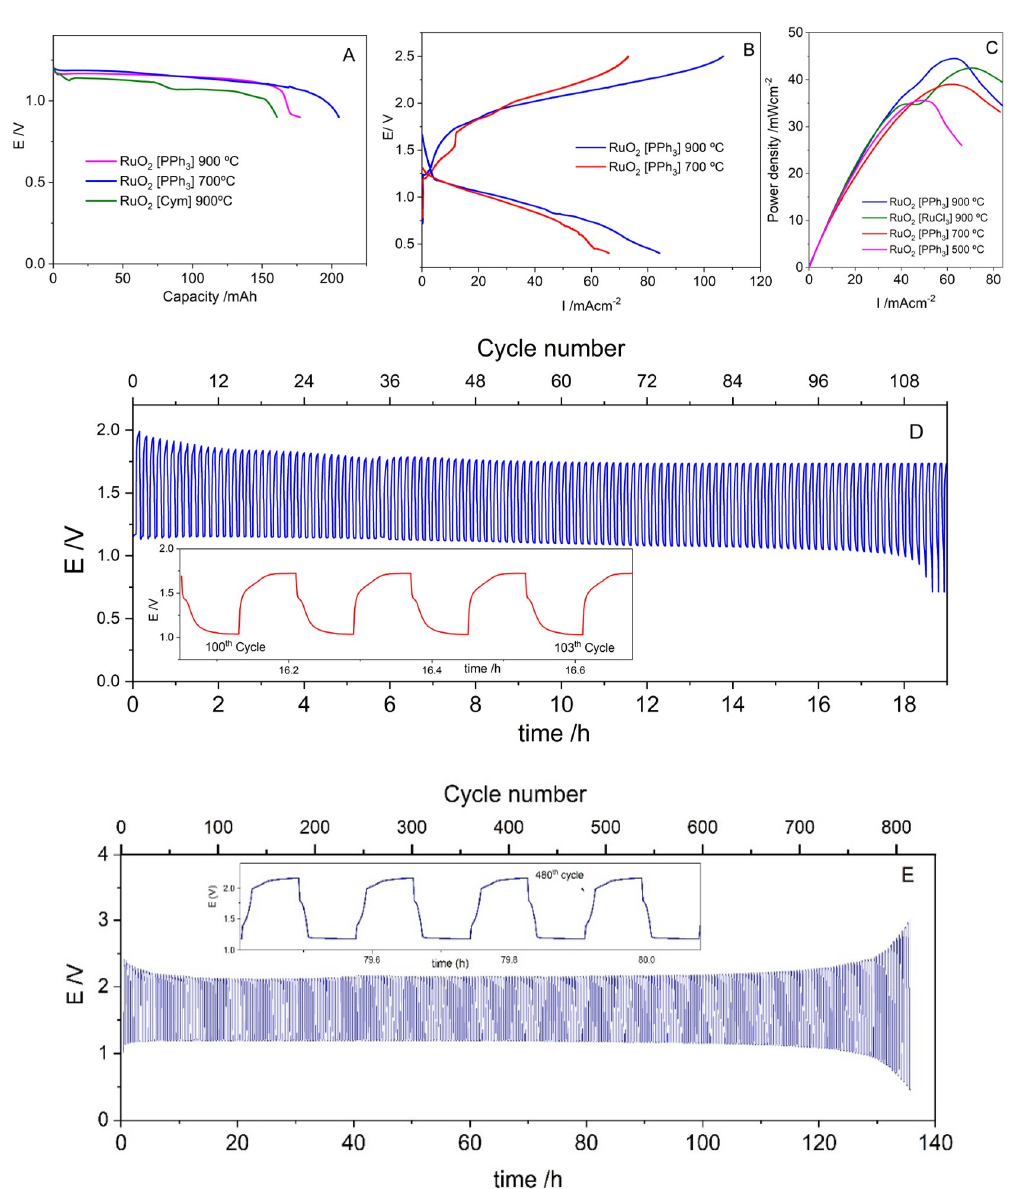
Figure 9. ( A ) Discharge curves of Zn/PVA − KOH/air ba tt eries at − 10 mA cm − 2 utilizing positive elec- trodes with the different catalysts. ( B ) Polarization curves for the discharge and charge processes of Zn/PVA − KOH/air ba tt eries, with RuO 2 [PPh 3 ] at 900 °C and 700 °C included in the air electrode. ( C ) Power vs. current densities obtained during the polarization tests of the Zn/PVA − KOH/air ba tt eries using air electrodes with different catalysts. ( D ) Discharge/charge cycles of a Zn/PVA − KOH/air bat- tery, adding RuO 2 [PPh 3 ] 900 °C as a catalyst in the air electrode. ( E ) Discharge/charge cycles of a flooded Zn/air battery in ⁓ 1mL 8M KOH solution, adding RuO 2 [PPh 3 ] 900 °C as the catalyst in the air electrode.